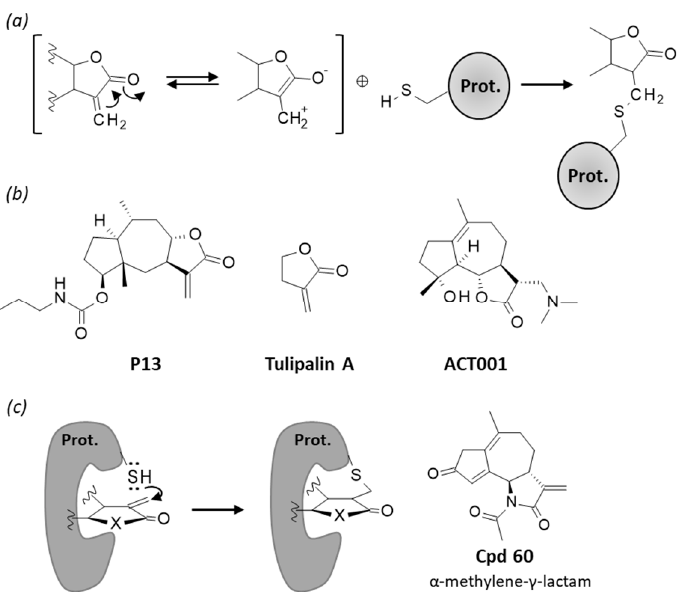
Figure 8. Thiol reactivity of BRT and related SLs. ( a ) Michael reaction between the highly reactive α -methylene- γ -lactone unit and an exposed sulfhydryl group of a protein to form a covalent drug– protein adduct (adapted from [4]). ( b ) Structures of compounds tulipalin A, P13 and ACT0001. ( c ) Structure of the reactive α -methylene- γ -lactam compound 60, acting as a covalent inhibitor of NF κ B. The compound has been shown to form stable adducts with cysteamine [145].